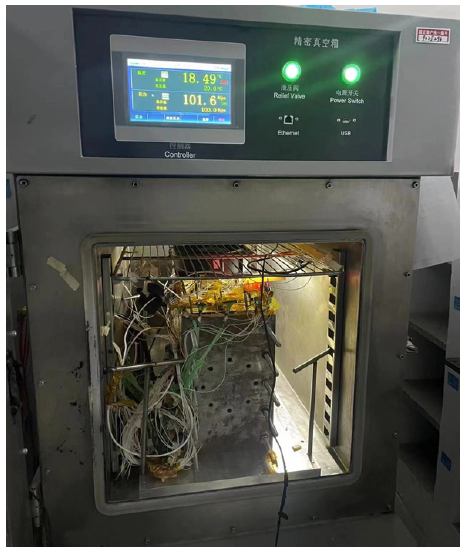
Figure 11. Lithium-ion battery capacity decay test.